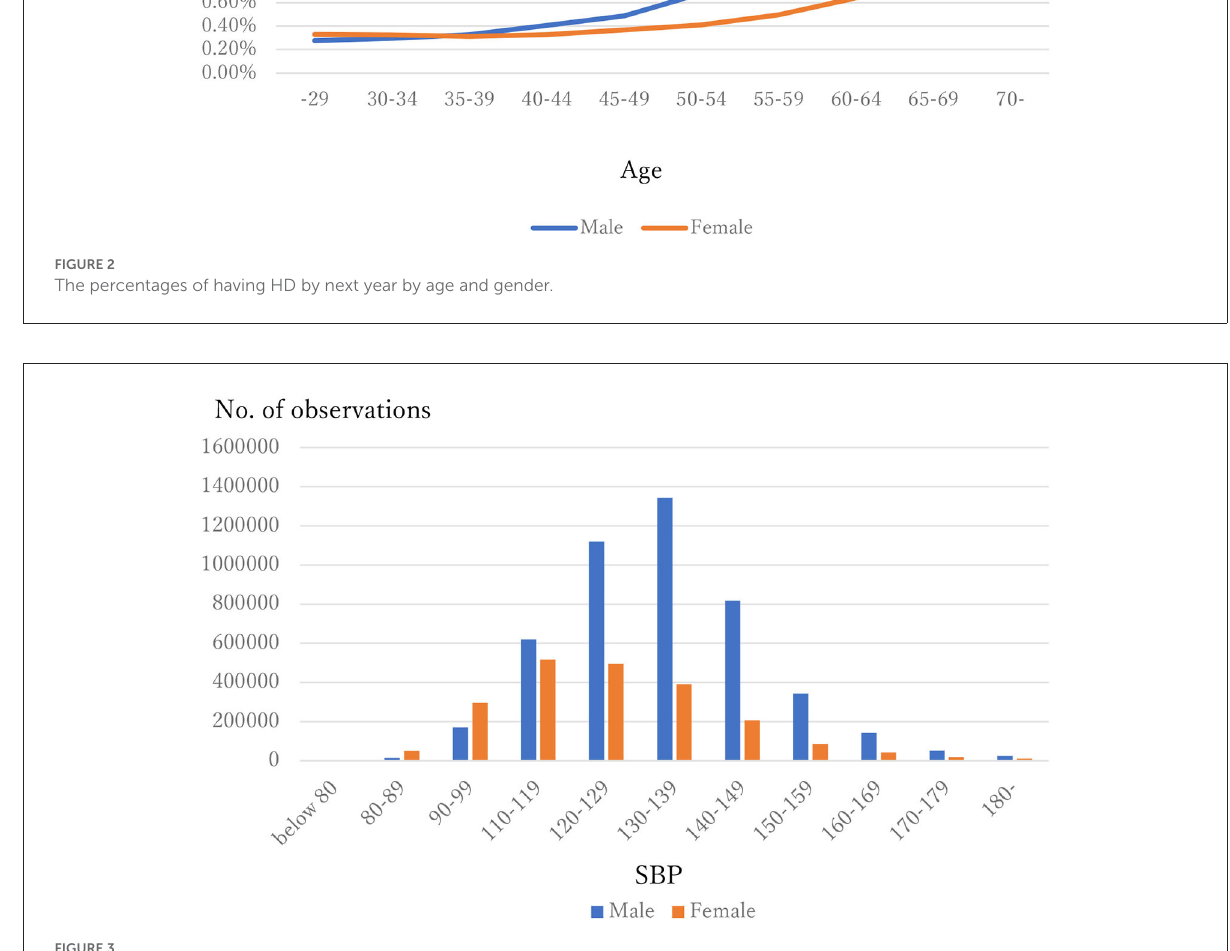
FIGURE3 The distribution of SBP by